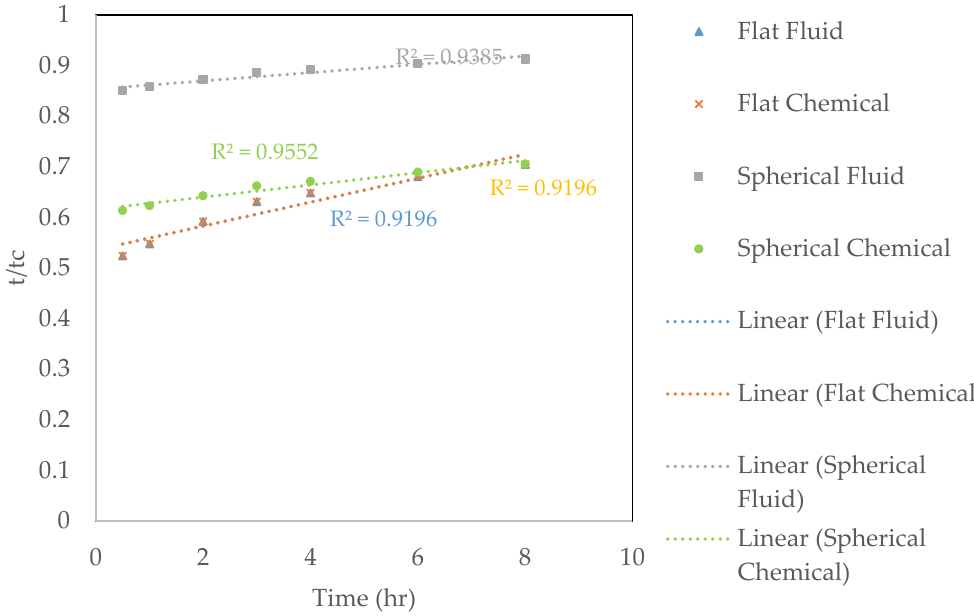
Figure 13. Kinetic calculation for a leaching trial in the presence of 0.776 M Br 2 and 0.166 M NaBr at 23.5 °C and 400 RPM.